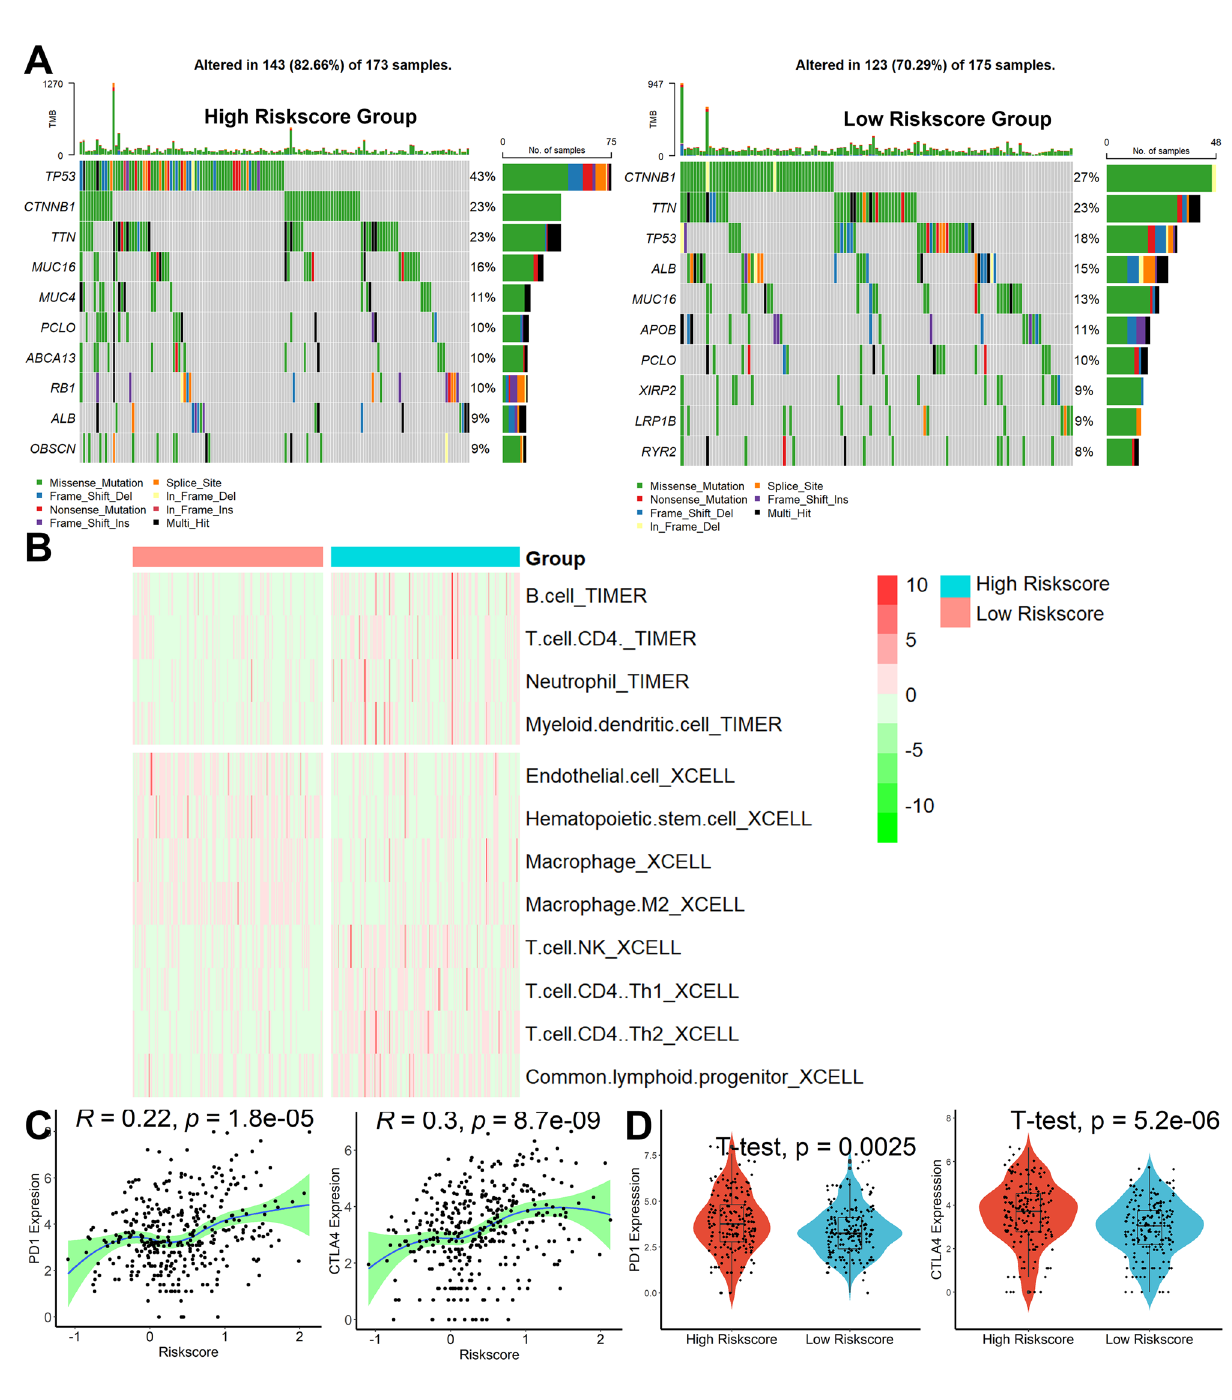
Figure 8. Genetic alterations and Immune Infiltrate Analysis. ( A ) Top 10 most substantially changed genes in the high- and low-risk score subgroups. ( B ) A heatmap of all substantially distinct immune cells between the high- and low-risk score subgroups. ( C ) Correlation analysis between risk scores and PD1, CATL4 expression. ( D ) Analysis of differences between risk scores and PD1, CATL4